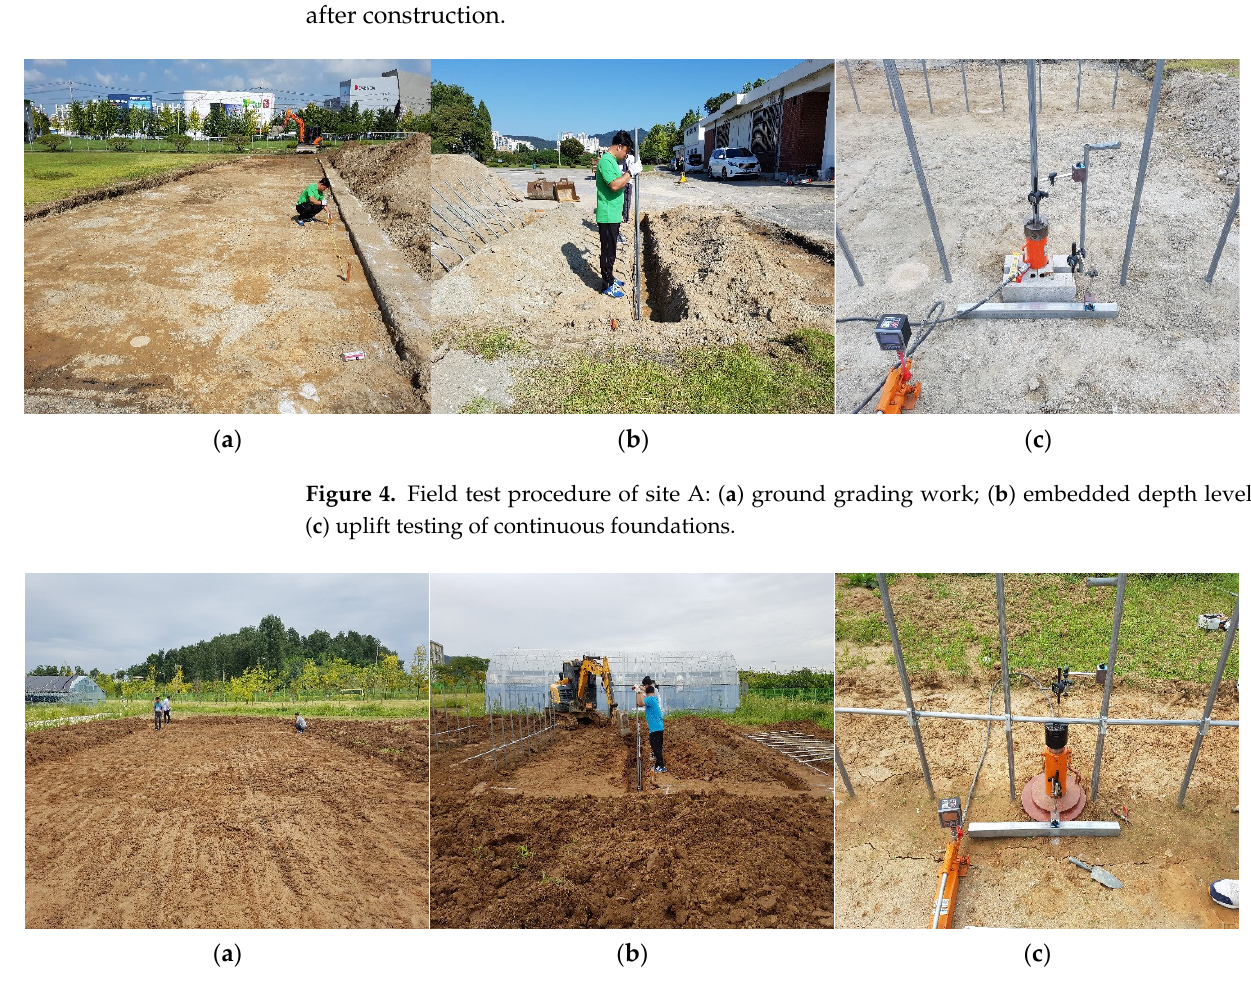
Table 3. Test condition identification number.